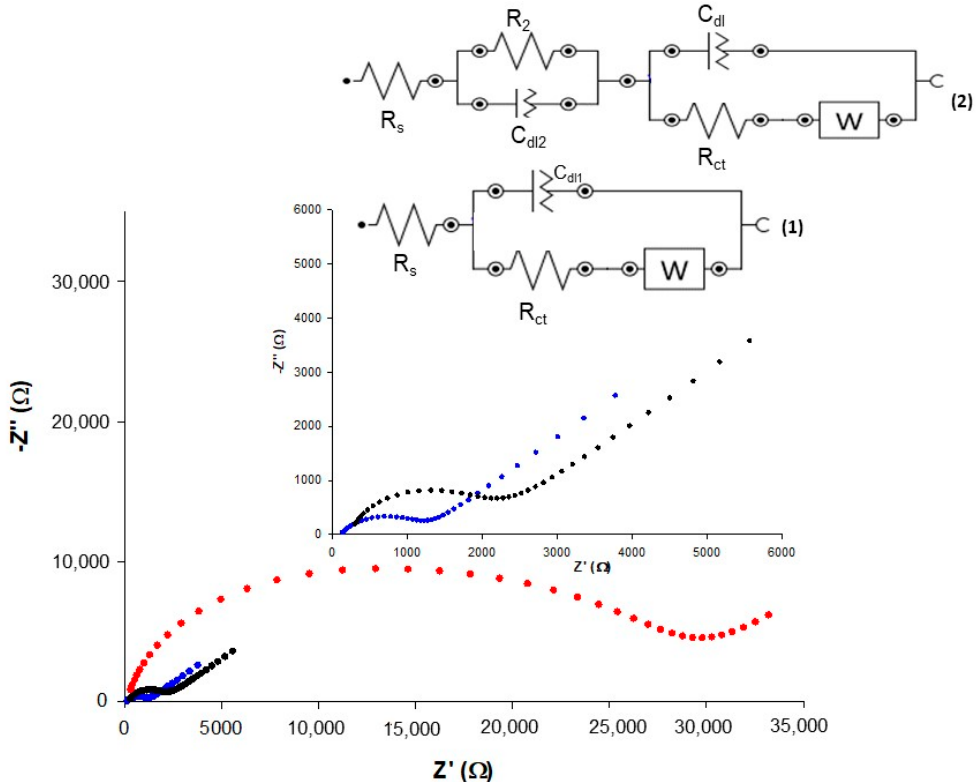
Figure 4. EIS response (Nyquist plots) of Au bare (blue curve), Au/SAMCys/OLNPs (black curve) and Au/KLNPs (red curve). The inset shows a magnification of blue and black curves and equivalent circuits used for fitting the experimental data, where ( 1 ) was used for Au bare and ( 2 ) for both modified electrodes. Experimental conditions: 5 mM Fe(CN) 63 − /Fe(CN) 64 − in PBS buffer (pH = 7.4) at 10 3 Hz.